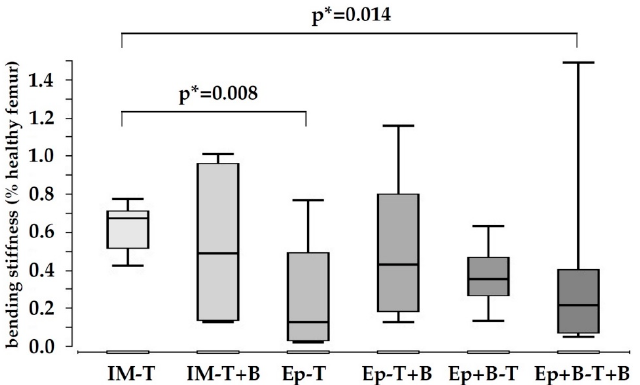
Figure 2. Bending stiffness of the 10 mm bone defect, in relation to the contralateral healthy femur (